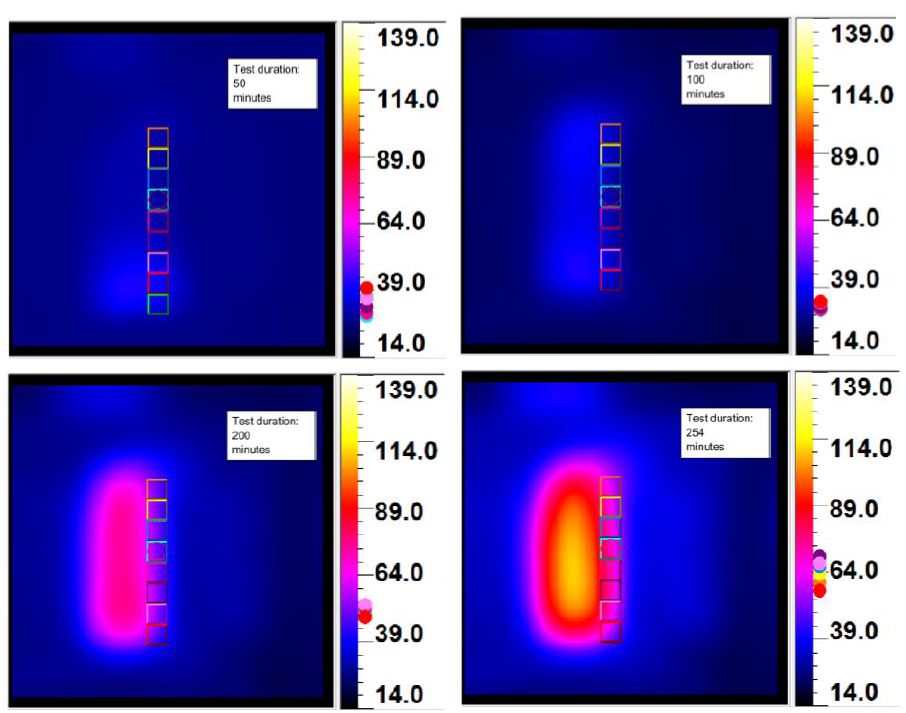
Figure 13. Temperature evolution for the SLC mix.